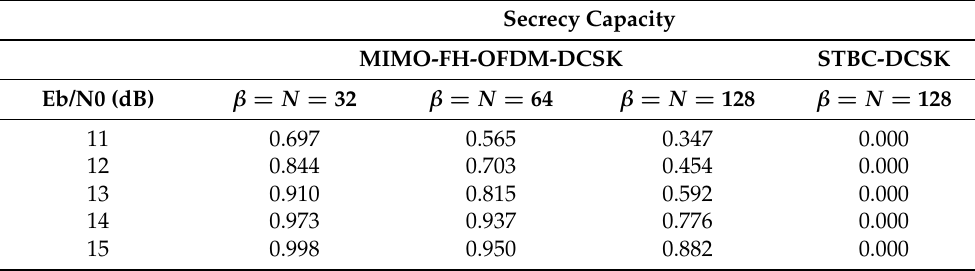
Table 4. Secrecy capacity comparison between the proposed system and the benchmark scheme (STBC-DCSK) [19,20] in the Rayleigh